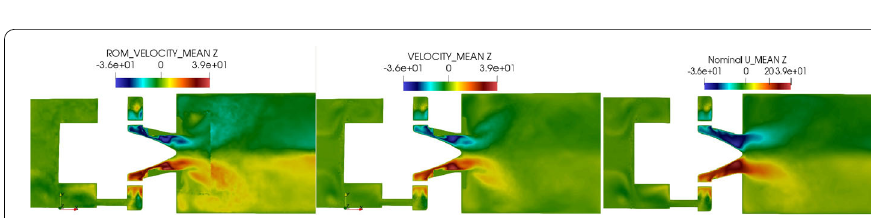
Fig. 42 On the left, the second component of the mean flow field by the UGPOD applied to configuration 1. In the middle, the second component of the high fidelity mean flow field with configuration 1. On the right, the second component of the high fidelity mean flow field with the nominal configuration